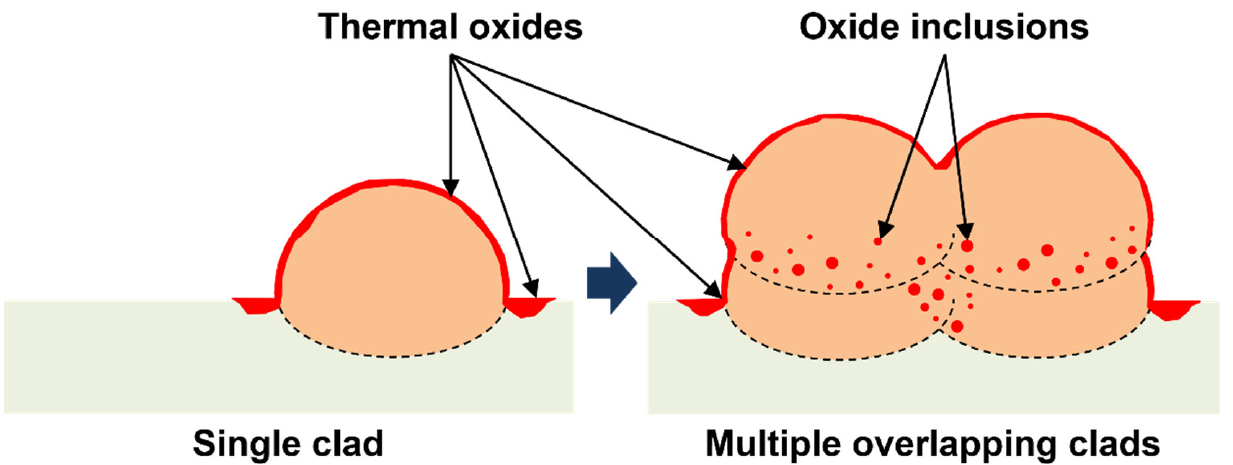
Figure 8. Schematic representing the formation of oxide inclusions from the thermal oxides formed on the HAZ and on the surface of the printed clads when multiple overlapping clads are deposited by DED.